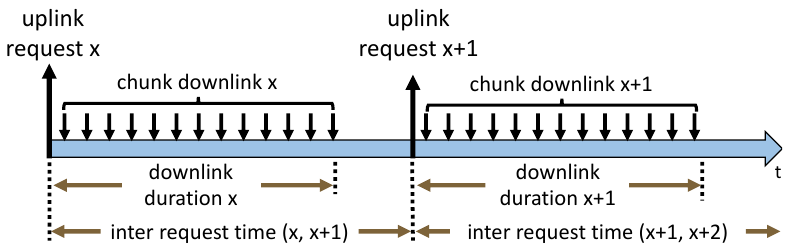
Figure 4. Timeline of YouTube chunk requests and associated data